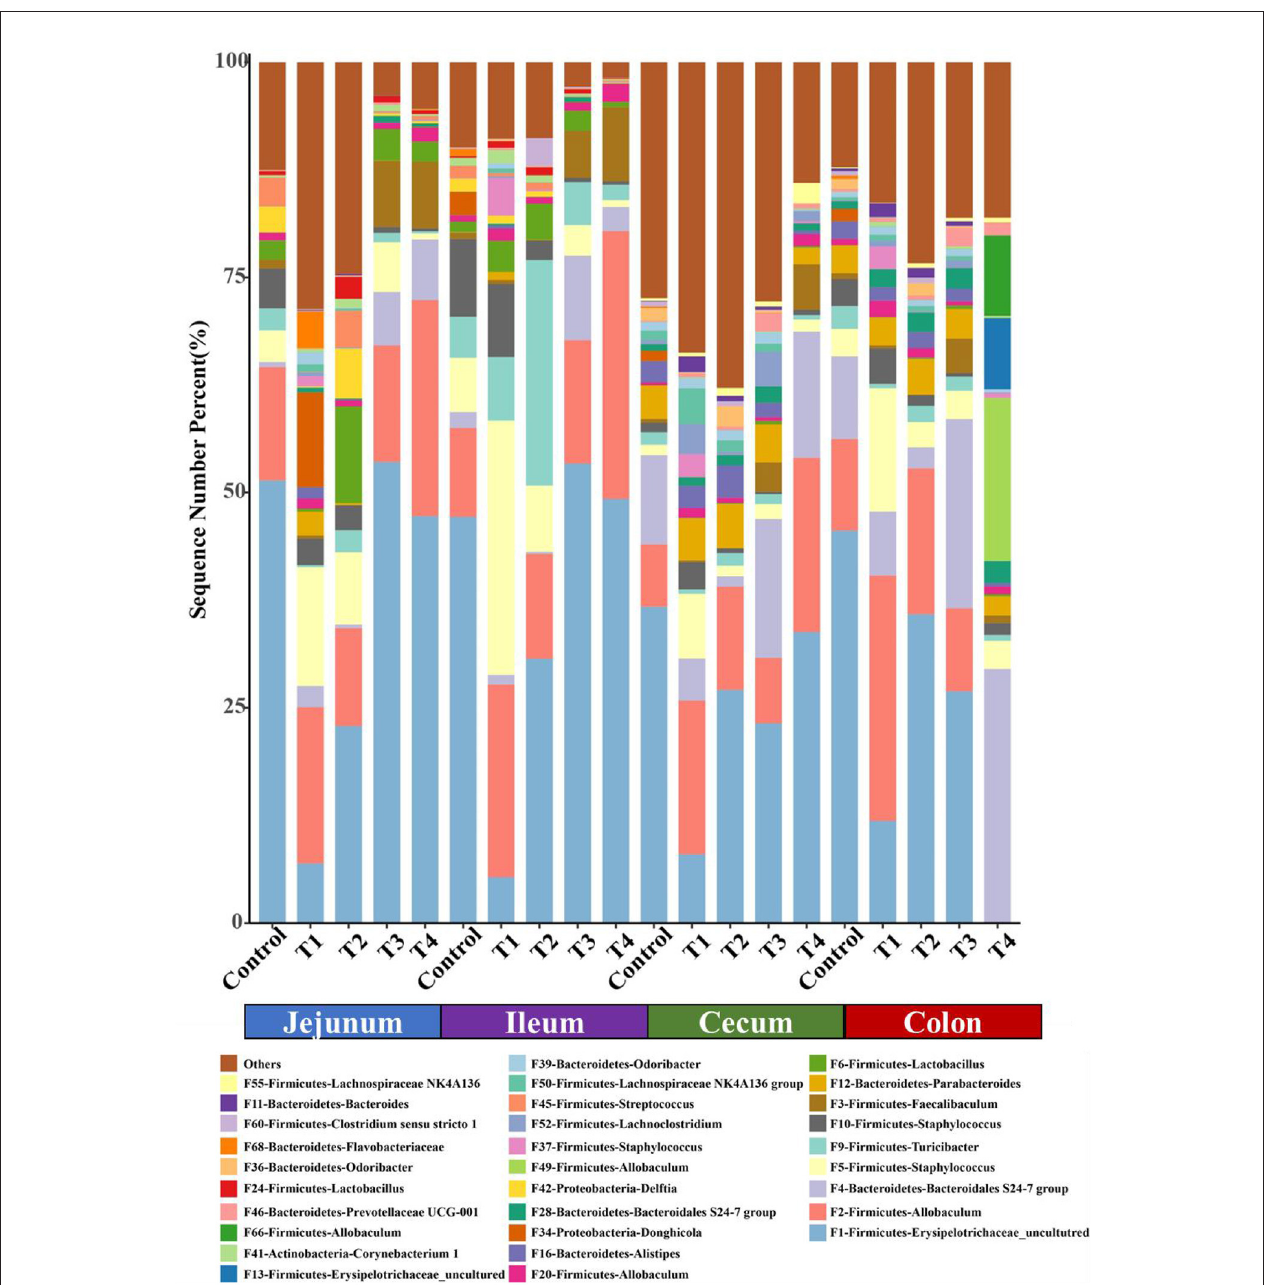
FIGURE 5 | The top 30 features in Control group and T1–4 groups of jejunum, ileum, cecum and colon microbiome in mice. Each color indicates the relative abundance of a bacterial taxon on the bar chart.